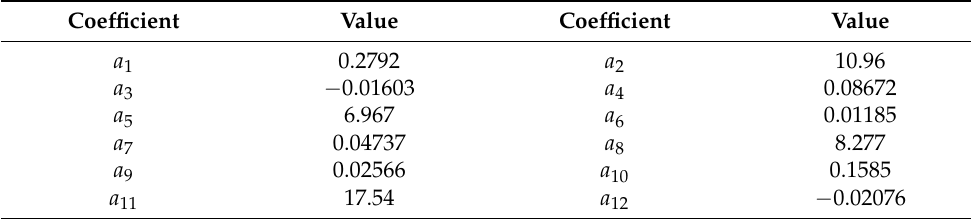
Table 5. The value of coefficients in R 2 - SOC - T fitting expression.